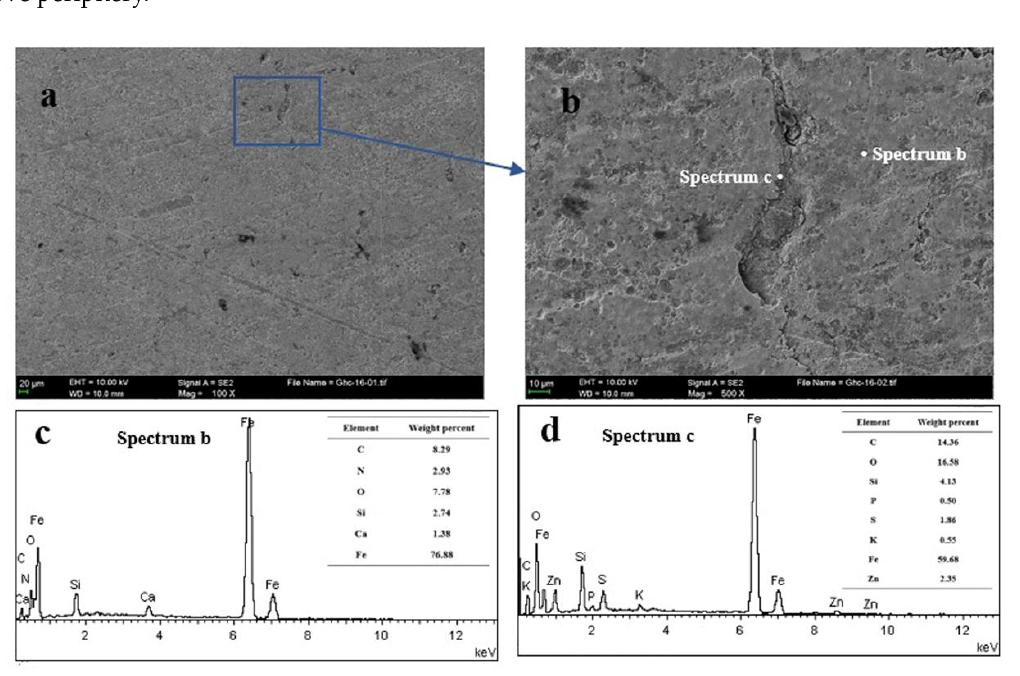
Surface Roughness after Running-in Test ( µ m)